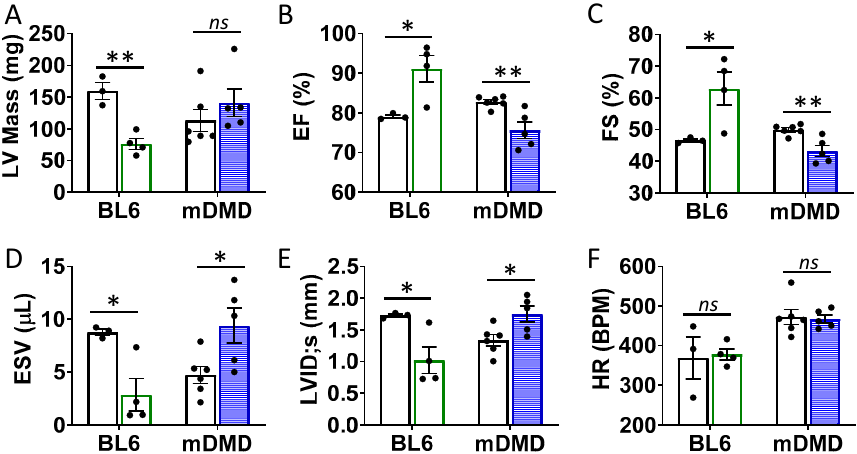
Figure 6. Val66Met leads to decreased ventricular function and increased end diastolic volumes in dystrophic mice. ( A ) Plot showing results of echocardiography assessment of mice with the rs6265 Val/Met polymorphism on a normal C57BL/6 (BL6, green bars) or mdx/mTR dystrophic (mDMD, blue bars) background relative to non-carrier controls (white bars). Parameters shown (y axis) are ( A ) left ventricular (LV) mass, ( B ) percent (%) ejection fraction (EF), ( C ) fractional shortening (FS), ( D ) end systolic volume (ESV), ( E ) left ventricular internal dimension at end systole (LVID;s) and ( F ) heart rate (HR). n = 4 (BL6), n = 5 (mDMD). Asterisks represent statistical significance. * p < 0.05, ** p < 0.01, ns = not